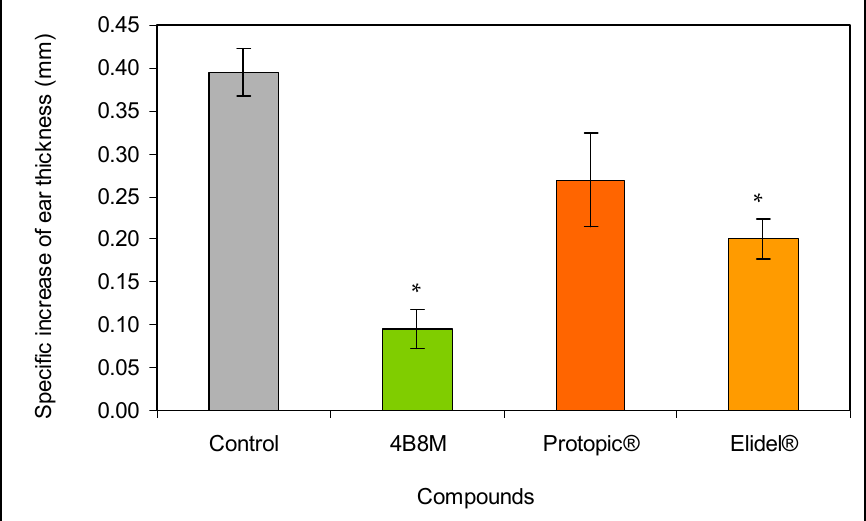
Figure 3. Effect of the 4B8M peptide and the reference drugs on antigen-specific increase of oxazolone-induced ear edema: the experiment was performed as described in Figure 2. The mice were treated topically with 4B8M (0.1% ointment) and the reference drugs at 24 h following elicitation of the antigen-specific reaction to oxazolone. The measurement of the ear edema was performed 24 h later, and the results are presented as the antigen-specific increase of the edema (by subtracting BG values). Mean values ± SE for respective groups are presented. * Control vs. compounds p < 0.05 (test of K-W).